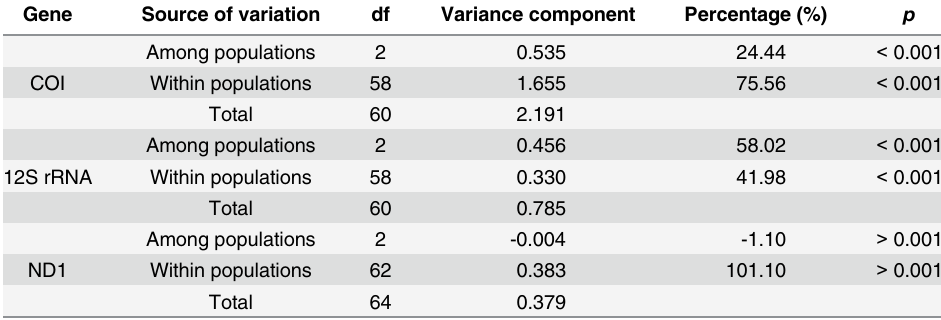
Table 8. Analysis of Molecular Variance Performed Using Macridiscus multifarius Populations. Gene Source of